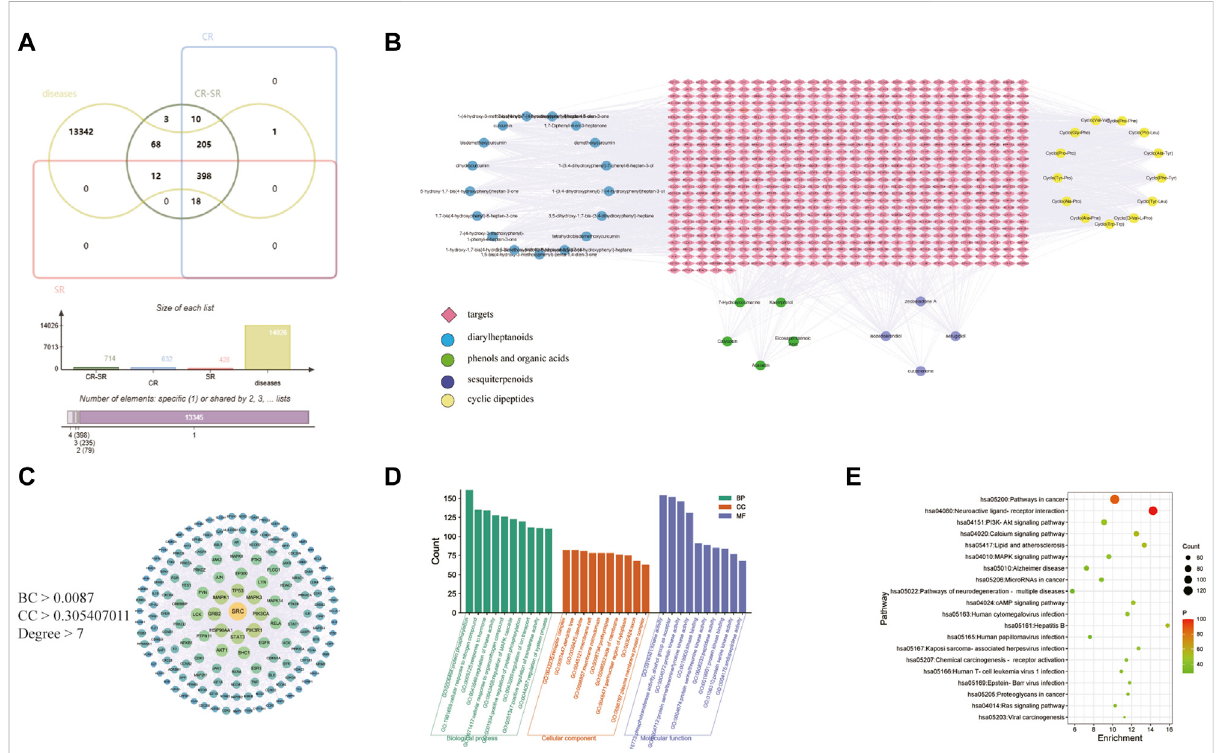
FIGURE 7 Network pharmacology of CR-SR in liver cancer treatment. (A) Venn diagram of active compound targets of CR-SR, CR, SR with liver cancer targets. (B) Active compound-target network of the overlapping targets between CR-SR and liver cancer (targets as orange diamond nodes; diarylheptanoids as blue circle nodes; phenols and organic acids as green circle nodes; sesquiterpenoids as purple circle nodes; cyclic dipeptides as yellowcirclenodes. (C) ThePPInetworkofthescreeningtargets. (D) Goenrichmentanalysis(top10). (E) Bubblediagramofenrichmentanalysis of KEGG pathway (top